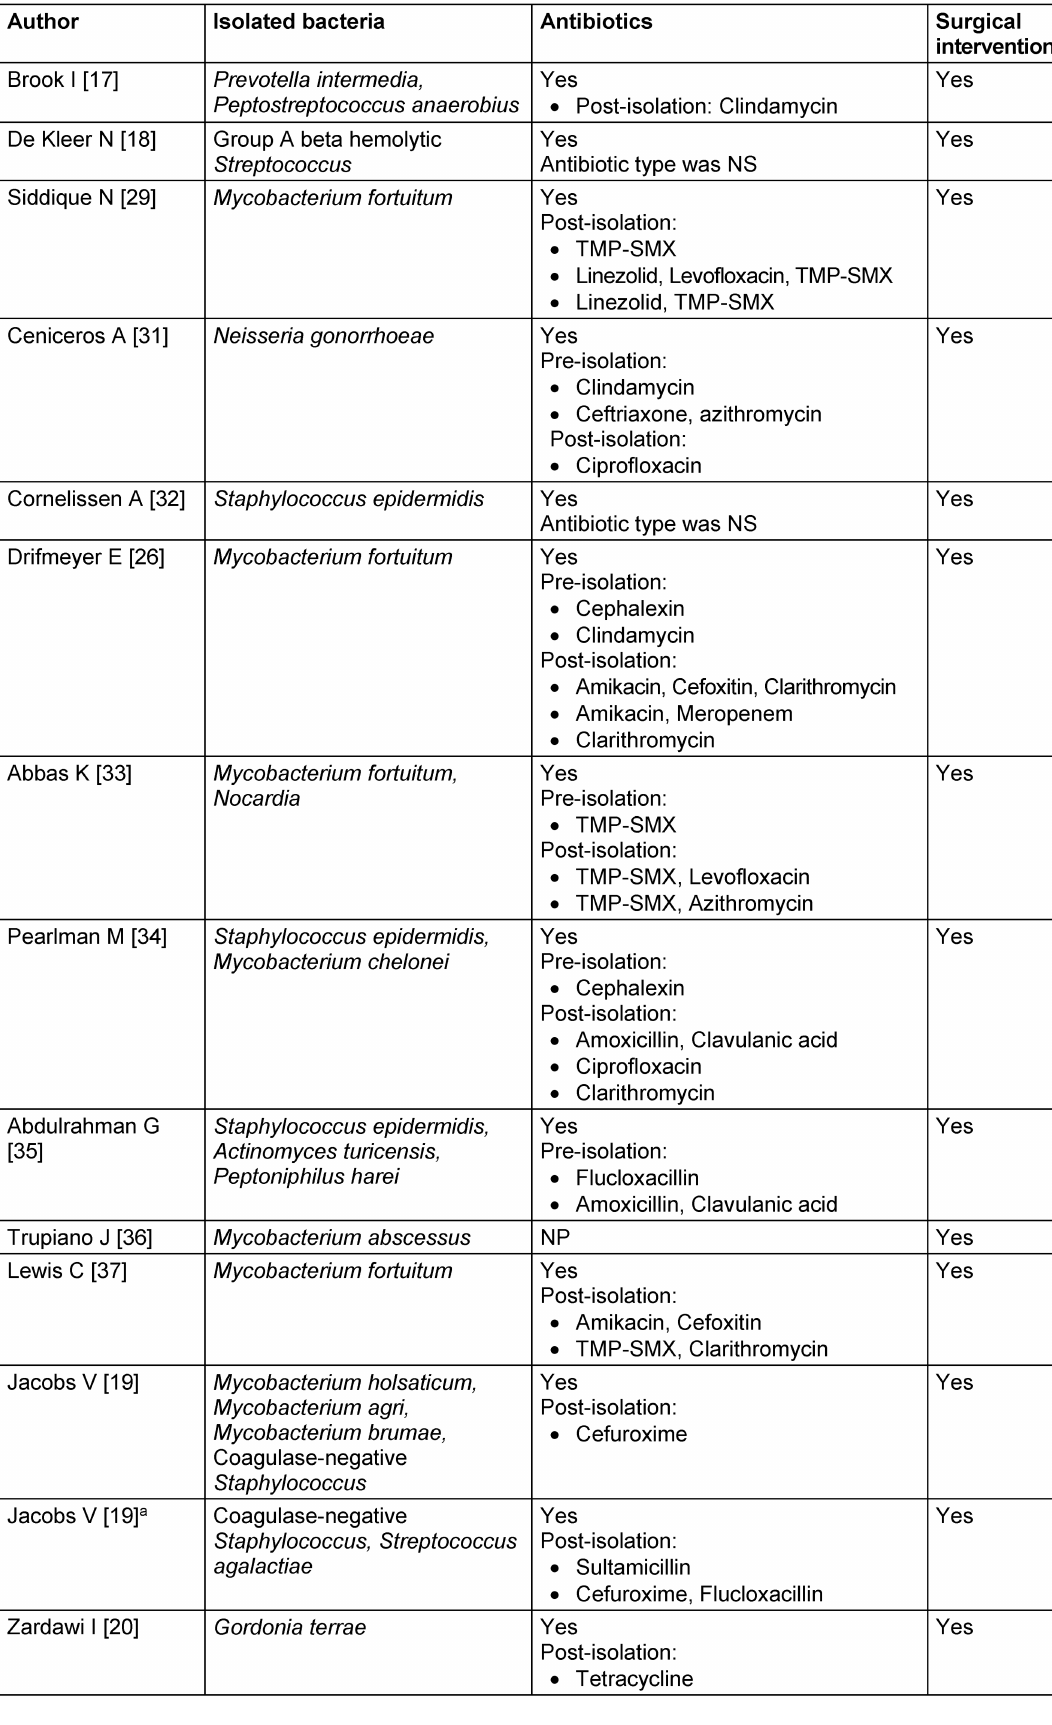
Table 3: Isolated bacteria and